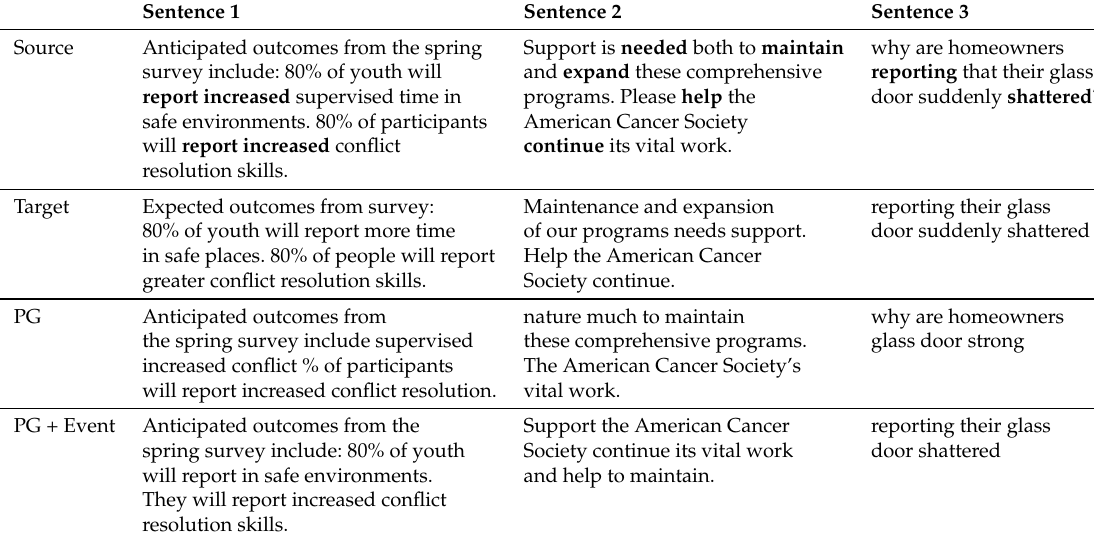
Table 6. Some examples of compressed sentences by compression